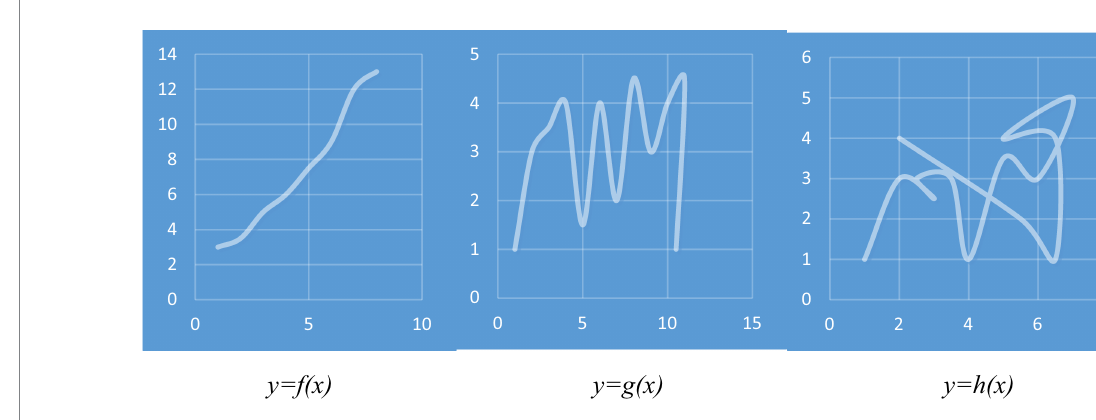
FIGURE 4 Three visual representations with different degrees of motor strength.